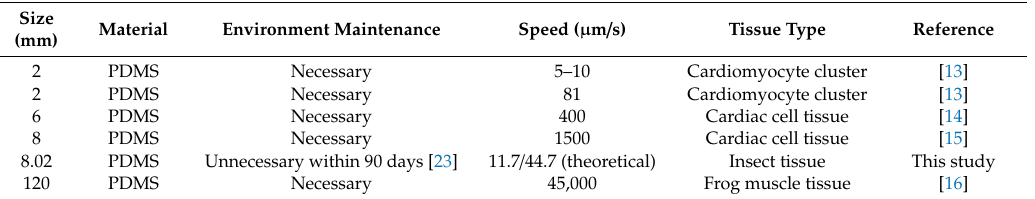
Table 2. Comparison between other tissue type-swimming robots and our insect muscular tissue-powered robot.